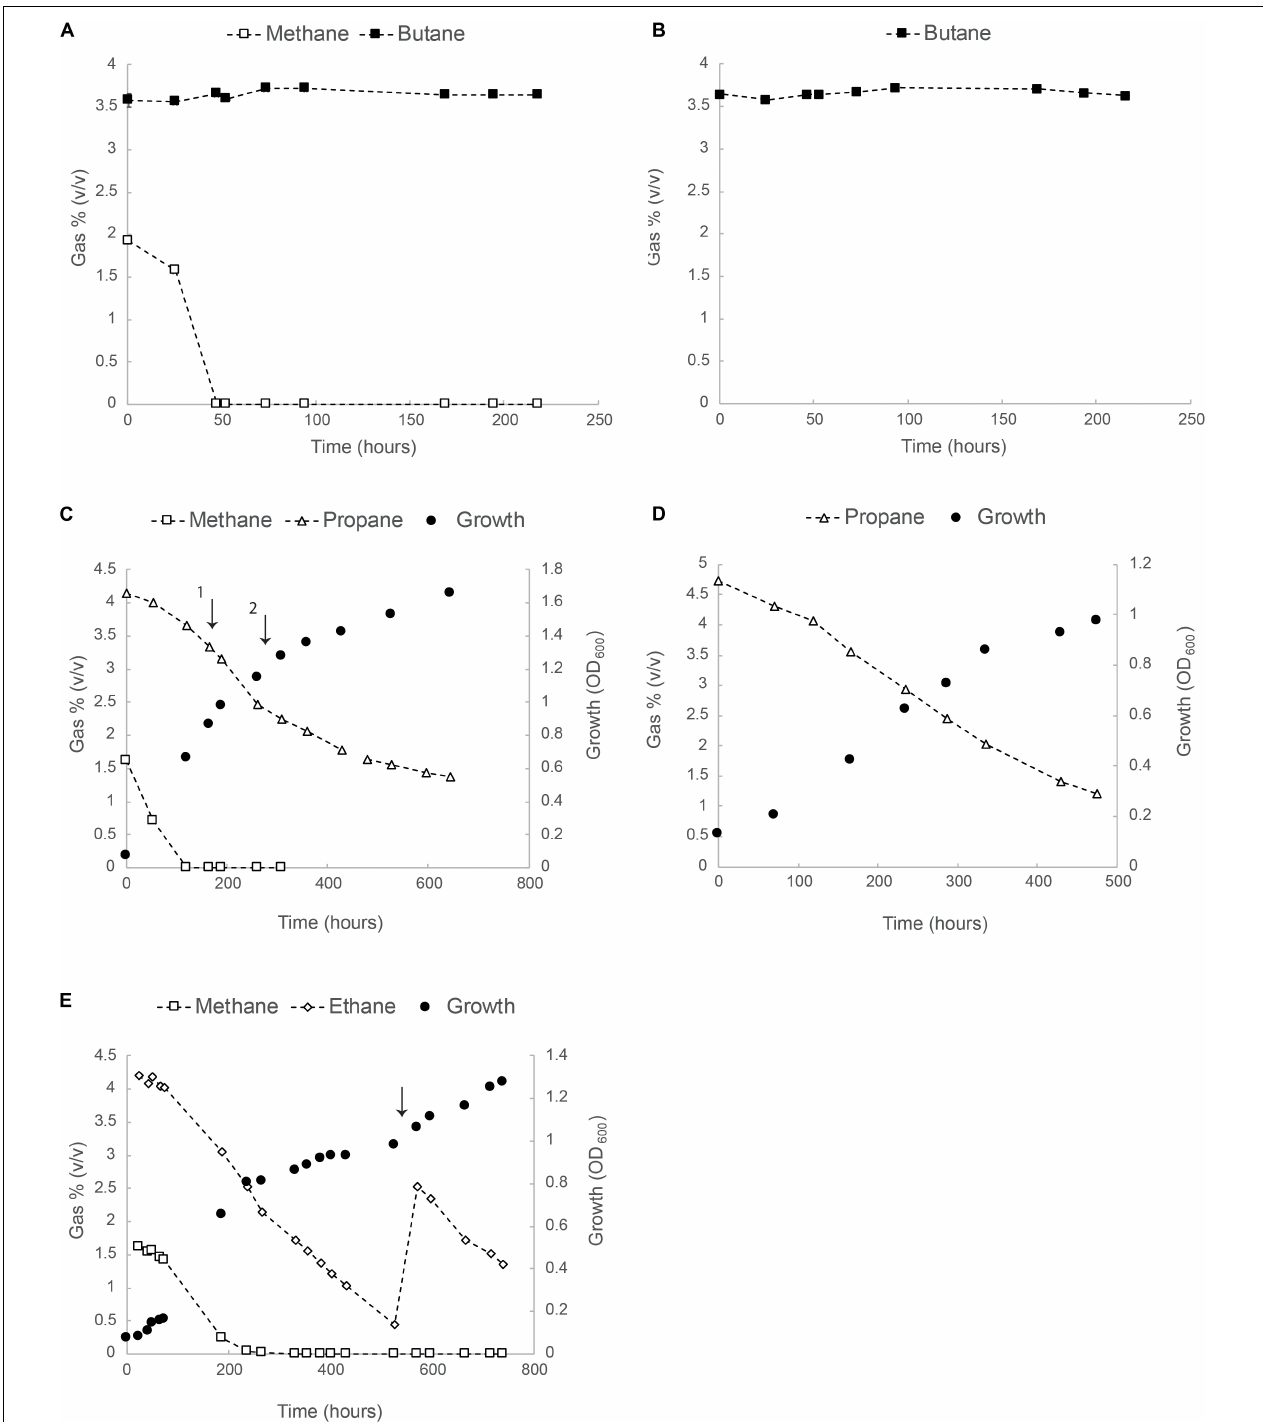
FIGURE 2 | Oxidation of butane, propane and ethane by strain SolV. (A) Consumption of methane and butane in batch cultures. (B) Butane concentration over time in batch cultures containing SolV cells. In panels (A,B) data points represent the average over three biological replicates. All error bars indicating standard deviation (SD) are smaller than the symbols. (C) Batch growth of strain SolV in serum bottles with methane/propane. The first arrow indicates an addition of 4 mM NH 4 + and 10 ml O 2 . The second arrow indicates an addition of extra trace element solution to avoid any limitation. (D) Growth of strain SolV with only propane using an inoculum from the incubation depicted in panel (C) . (E) Growth of strain SolV with methane and ethane mixture, followed by a growth only using ethane. The arrow indicates an addition of 5 ml ethane, 10 ml O 2 , 4 mM NH 4 + and extra trace elements. In panels (C–E) , data points represent the average over two biological replicates.